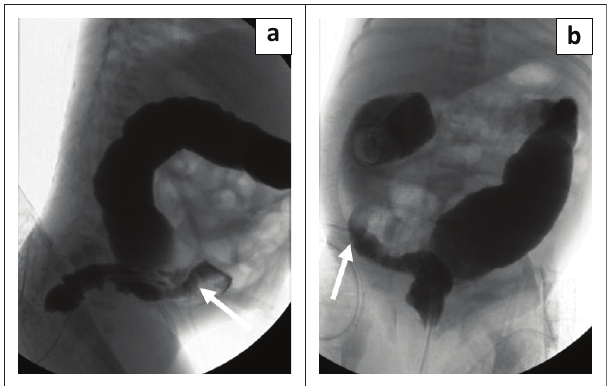
FIGURE 1: Lateral (a) and frontal (b) views demonstrating long segment Hirschsprung disease involving the rectum and distal sigmoid colon, with a transition zone (white arrows) seen in the sigmoid